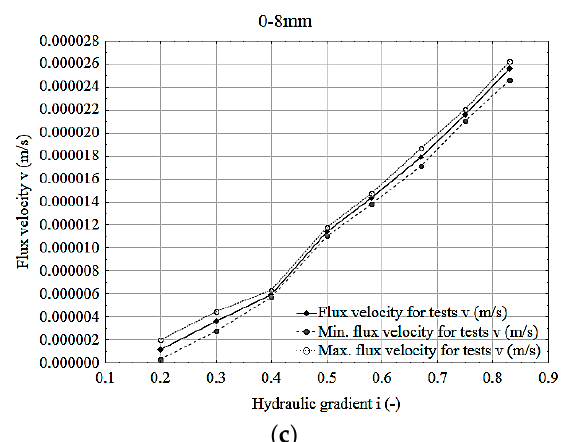
Figure 7. Prediction of the threshold gradient on the basis of the characteristic linear trend line with the minimal and maximal value flux velocities. ( a ) blend 0.05–16 mm; ( b ) blend 0–16 mm; ( c ) blend 0–8 mm.